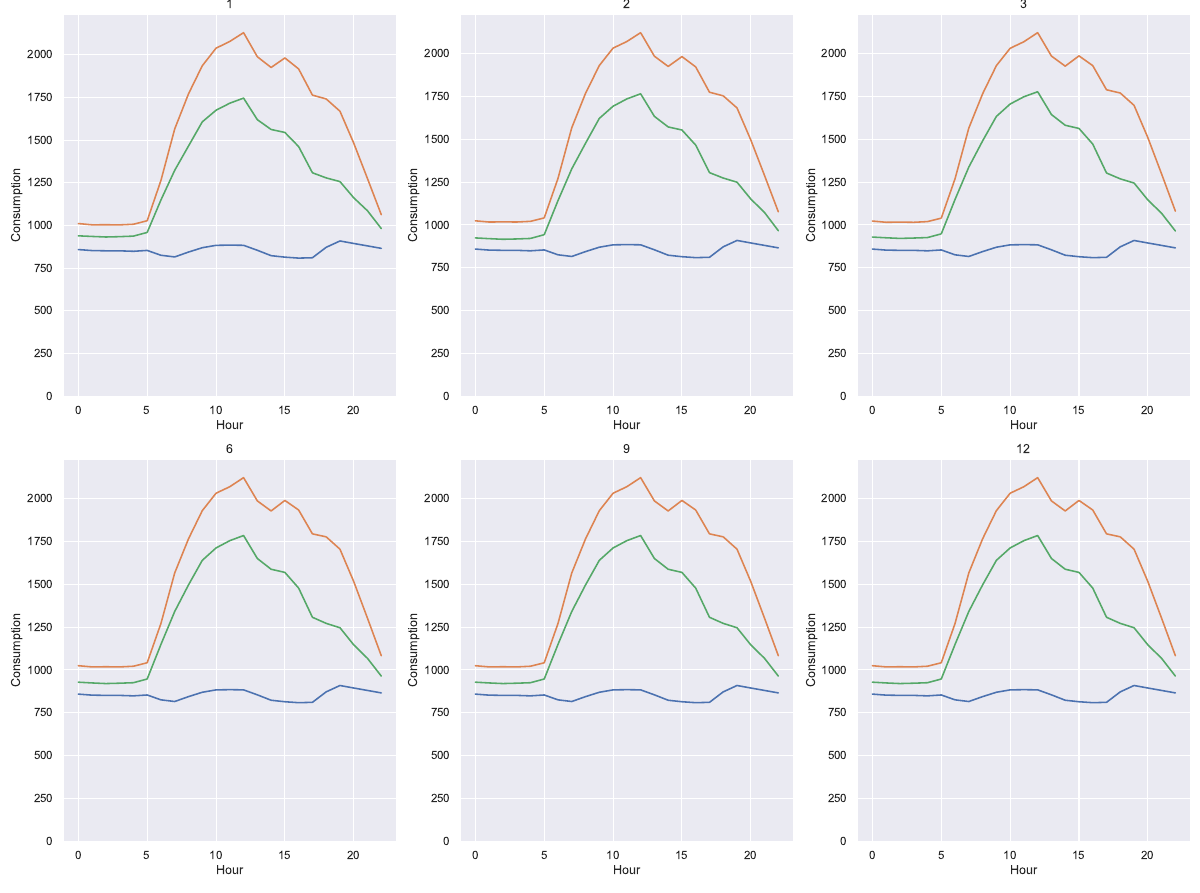
Figure 13. Cluster prototypes for PCA. Each color represents a single cluster.